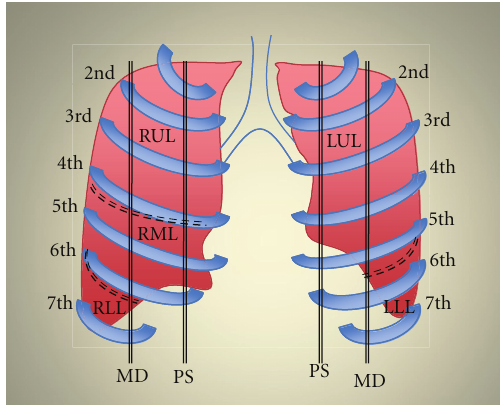
Figure 1: Anterior view of the lung. Schematic representation of pulmonary lobes in relation to ribs and intercostal spaces along parasternal (PS) and midclavicular (MD) lines, respectively. Dashed lines correspond to major and minor lung fissures (RUL: right upper lobe; RML: right mid lobe, RLL: right lower lobe; LUL: left upper lobe; LLL: left lower lobe).